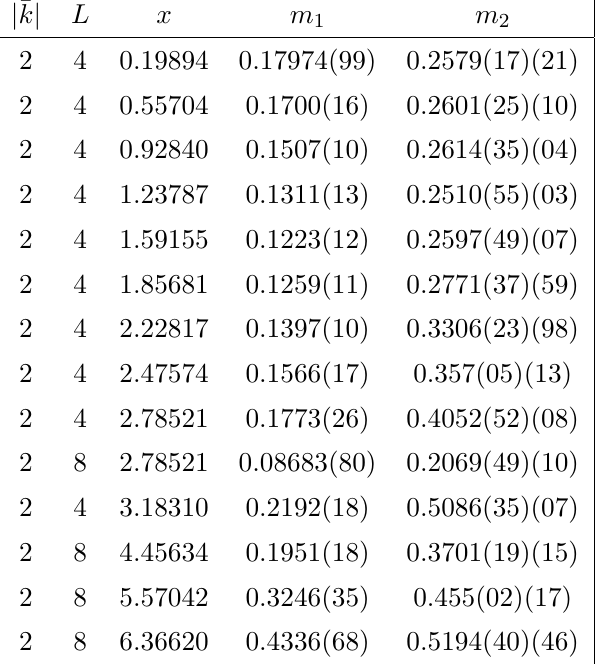
Table 25. Mass gap and next excited state energy (in lattice units) in the zero-electric (cid:13)ux scalar sector for